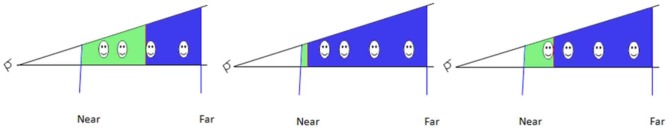
Split schemes, Left: Uniform splitting, Center: Logarithmic splitting, Right: Practical splitting.